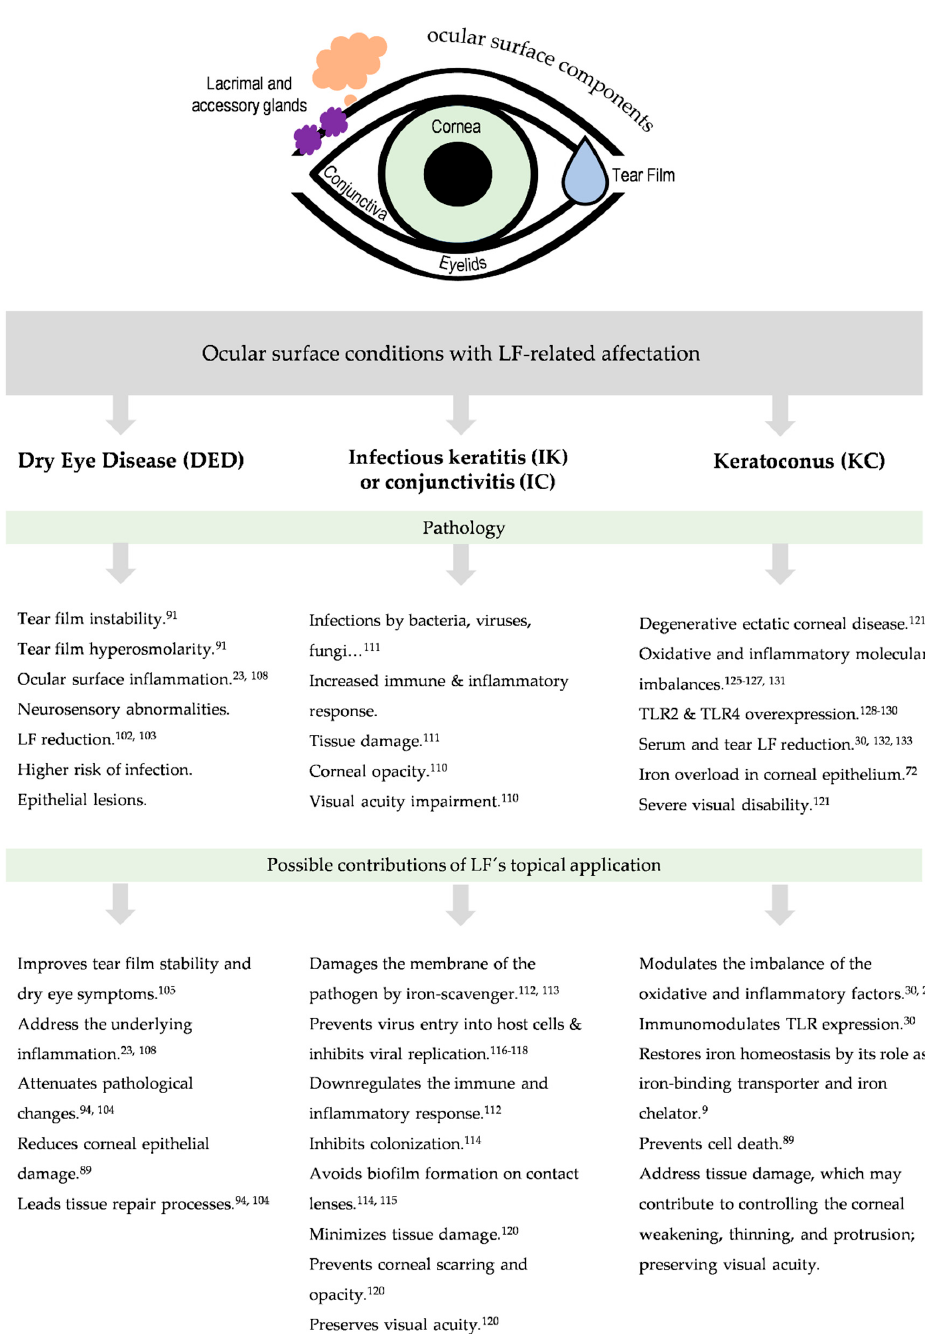
Figure 5. Schematic summary of the main ocular surface conditions with LF-related affectation, along with the potential beneficial contributions that LF could make to their pathology. Self-created figure using elements with Creative Common (CC) license. The superscript numbers belong to the references cited in this manuscript